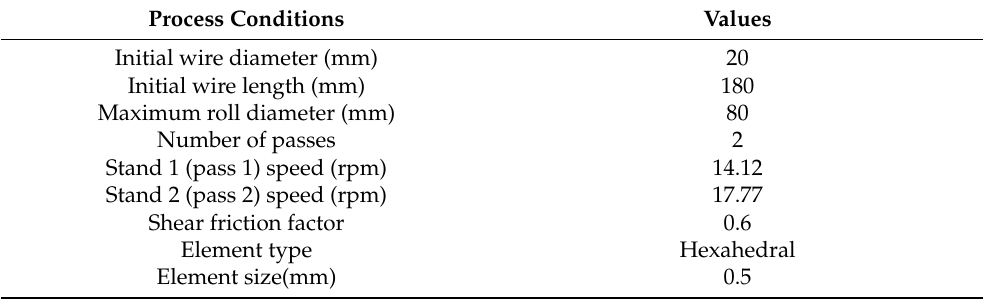
Figure 4. Flow stress curves of aluminum alloy 7075 for different temperatures.